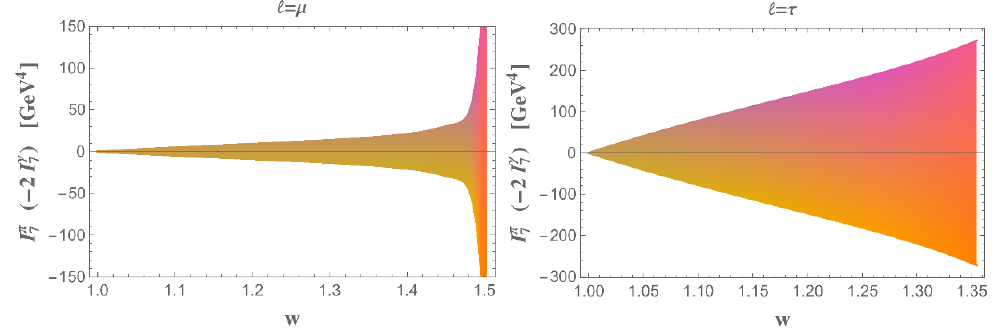
Figure 9 . Coe(cid:14)cient I 7 in eq. (3.1) for ‘ = (cid:22) and (left), and ‘ = (cid:28) (right). The coe(cid:14)cients (cid:15) (cid:22) and (cid:15) (cid:28) are varied in the low (cid:31) 2 region displayed in (cid:12)gure 6. I 7 does not vanish when the tensor T operator is included in the e(cid:11)ective Hamiltonian.